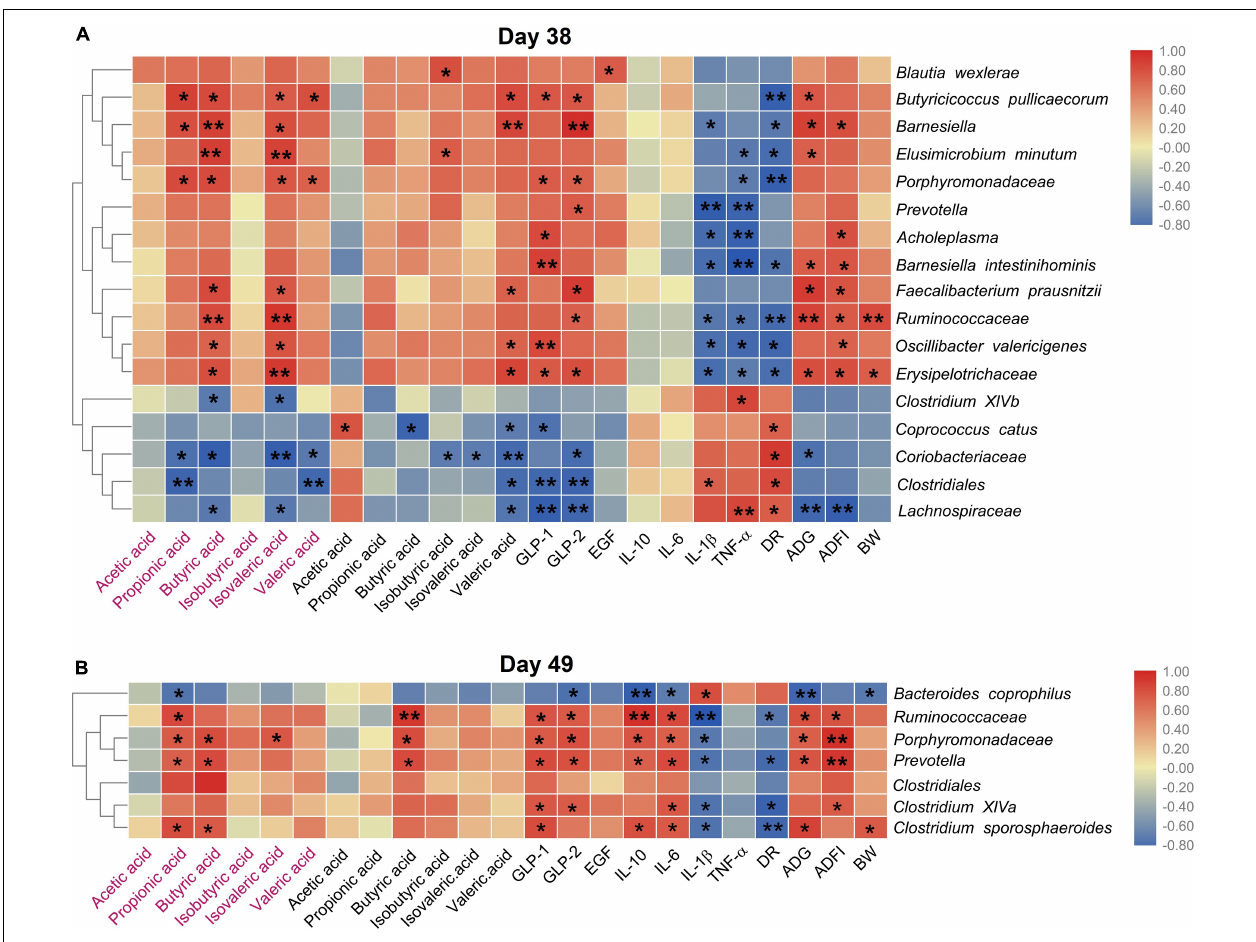
FIGURE 6 | Heat map of the spearman’s rank correlation coefficient between the microbial species and the growth performance, the metabolites, the cytokines, endocrine peptides, the growth performance on day 38 (A) and day 49 (B) , respectively. In the figure, the blue color represents the negative correlation while red color represents a positive correlation. The words in red represents the SCFAs concentration of colonic digesta, and the words in normal black represents the SCFAs concentration in ileal digesta. Significance were presented as * P < 0.05, and ** P < 0.01, n = 4 or